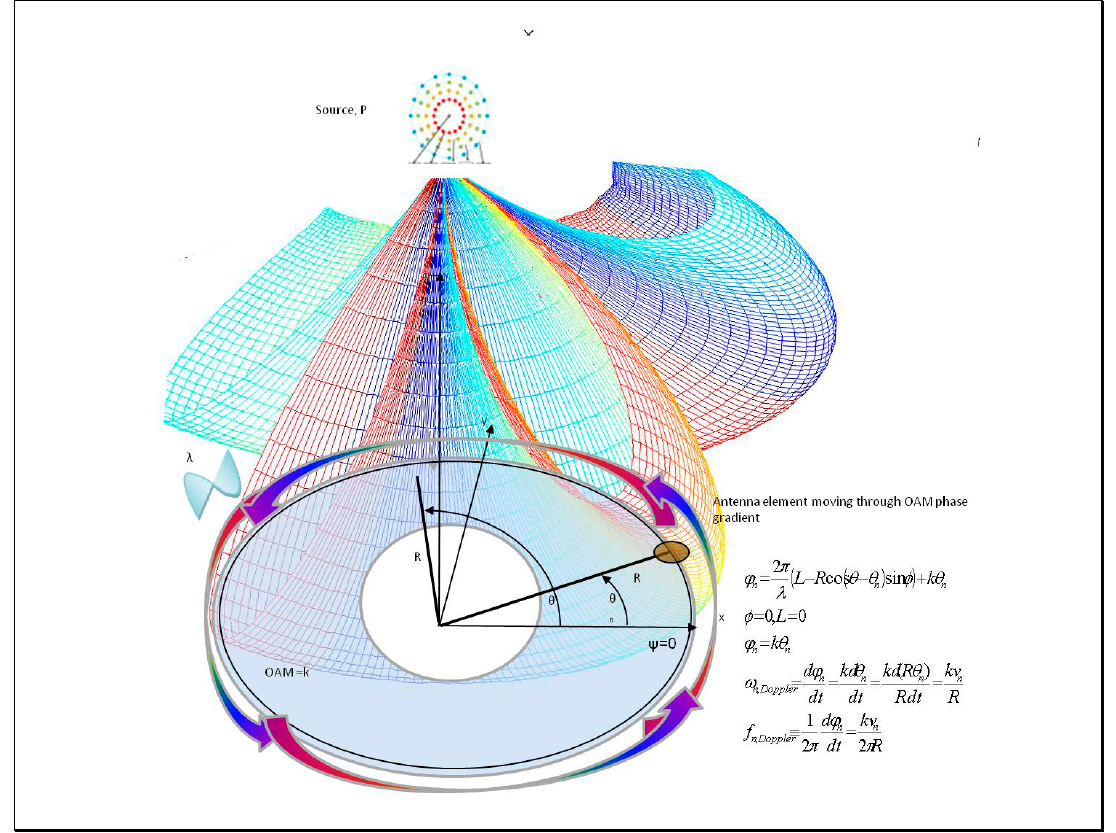
Figure 3. Receiving antenna moving through OAM beam.